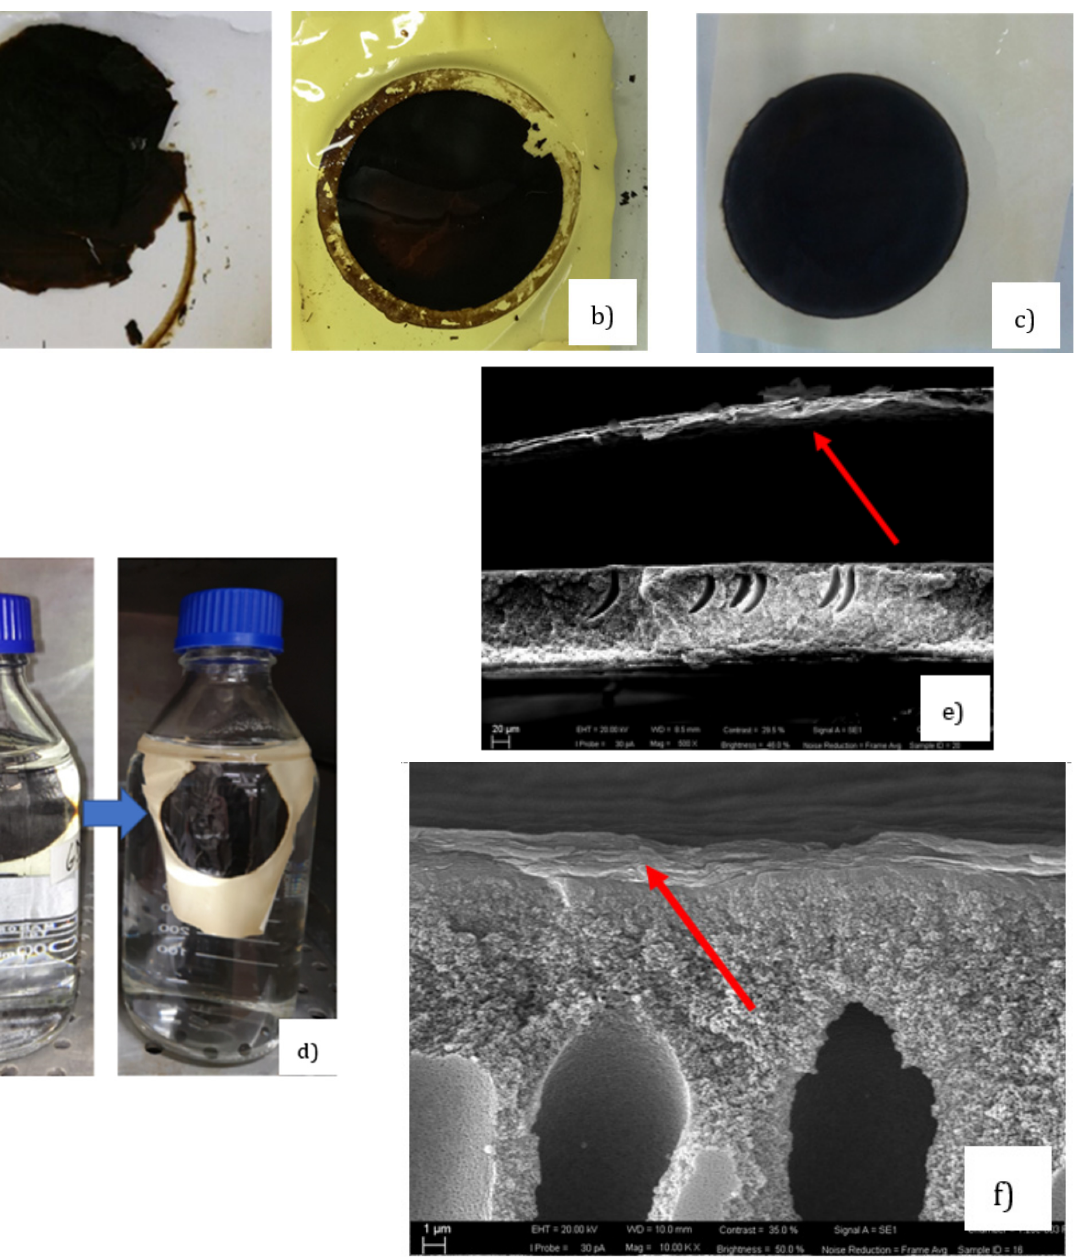
Figure 1. Picture of ( a ) GO-PVDF, ( b ) GO-PAI, ( c ) GO–PAI-cr immersed in water at room temperature immediately after their preparation; ( d ) GO-PAI-cr immersed in water at 60 °C for 30 days (left: as immersed; right after 30 days); ( e ) SEM image of the GO layer detached from the PVDF support and ( f ) SEM image of the GO layer adhering well on PAI-cr (red arrow shows the GO layer position). Complementary to the experimental characterization and analysis of the pristine and the crosslinked polyamide–imide GO composites (GO-PAI and GO-PAI-cr) and the GO-